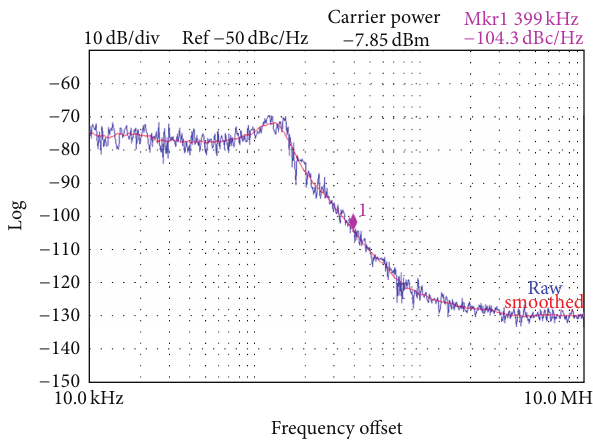
Figure 13: Measured phase noise of fractional-N PLL.